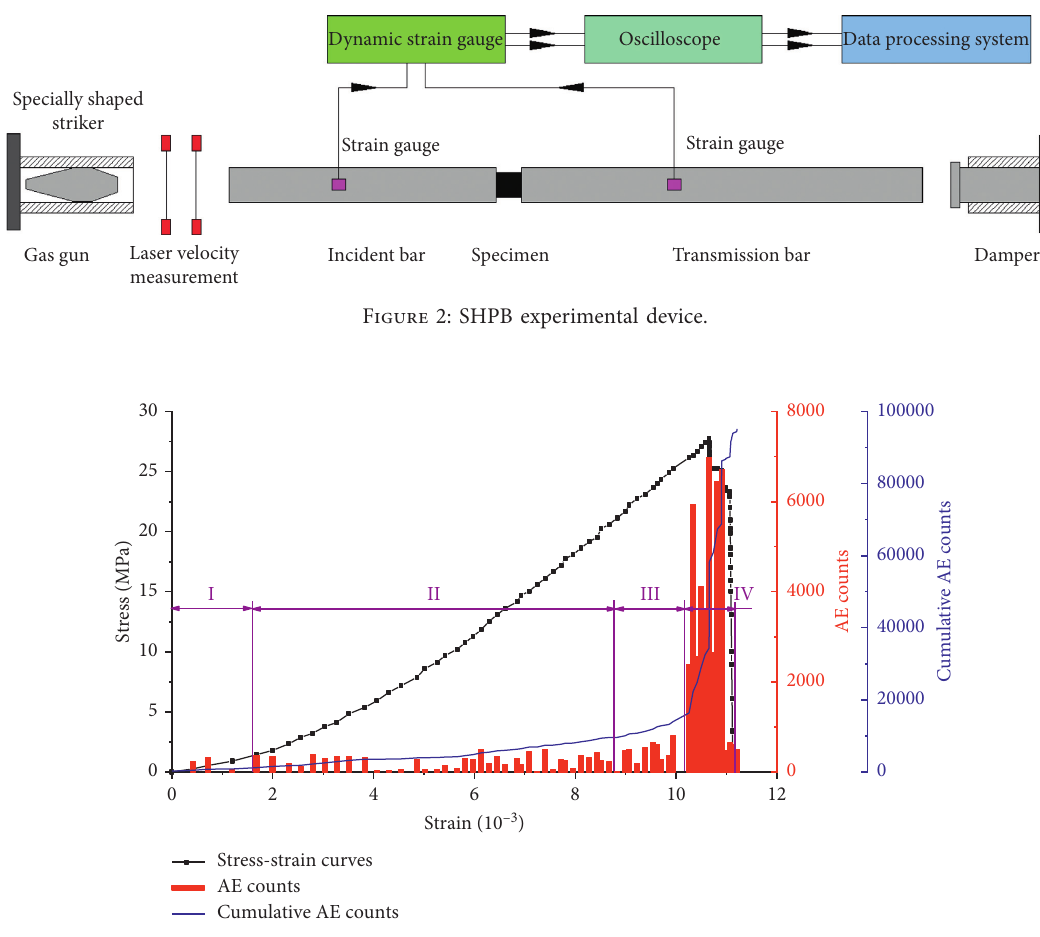
Figure 3: Stress-strain curve and acoustic emission monitoring curve of unimmersed raw coal